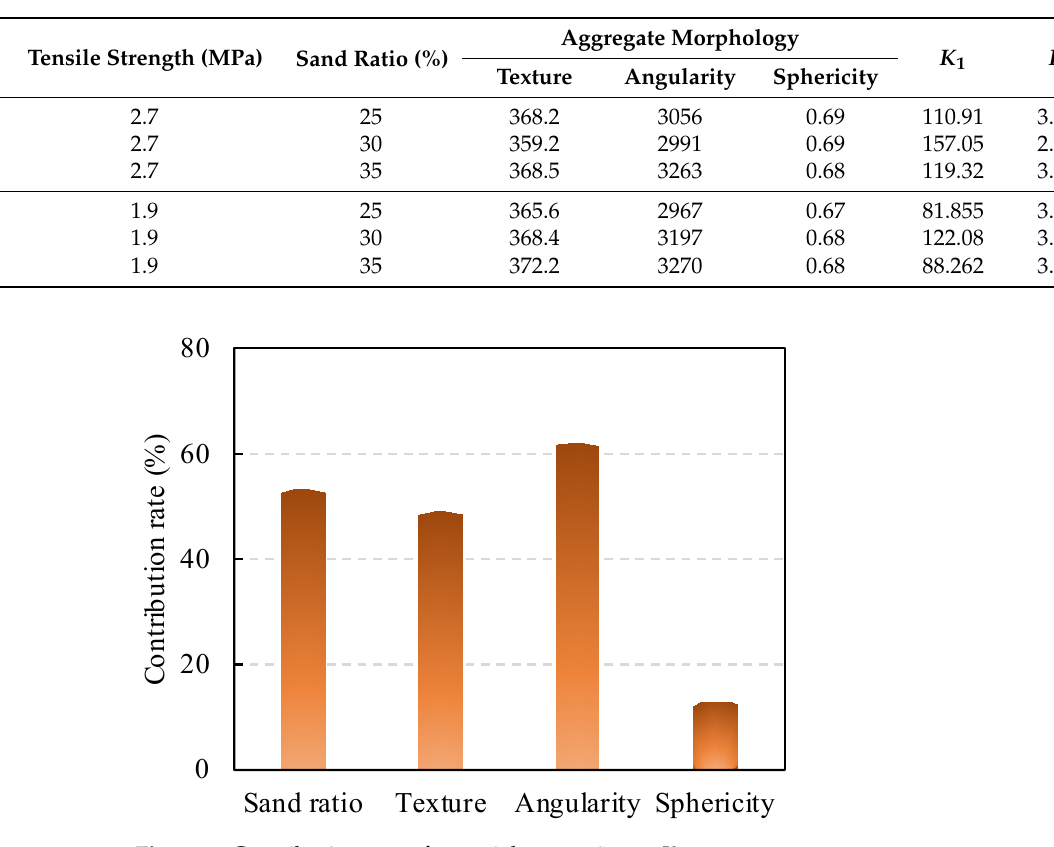
Table 7. Relationships between materials properties and predicted parameters.